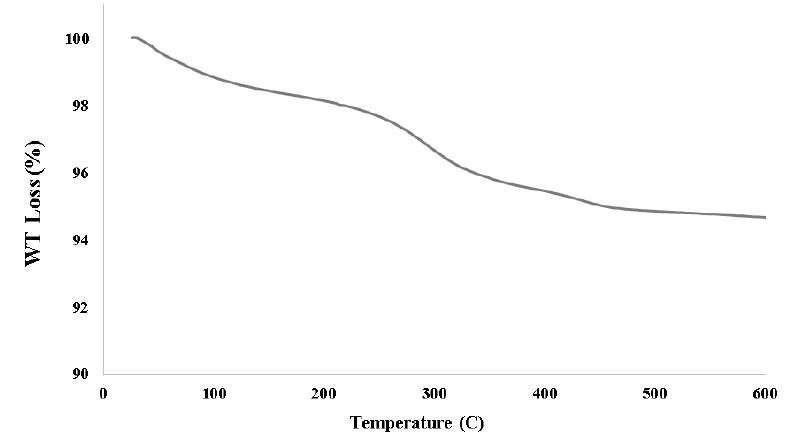
Fig. 6. TGA diagram of ZnFe Figure 6: TGA diagram of ZnFe 2 O 4 nanoparticles.